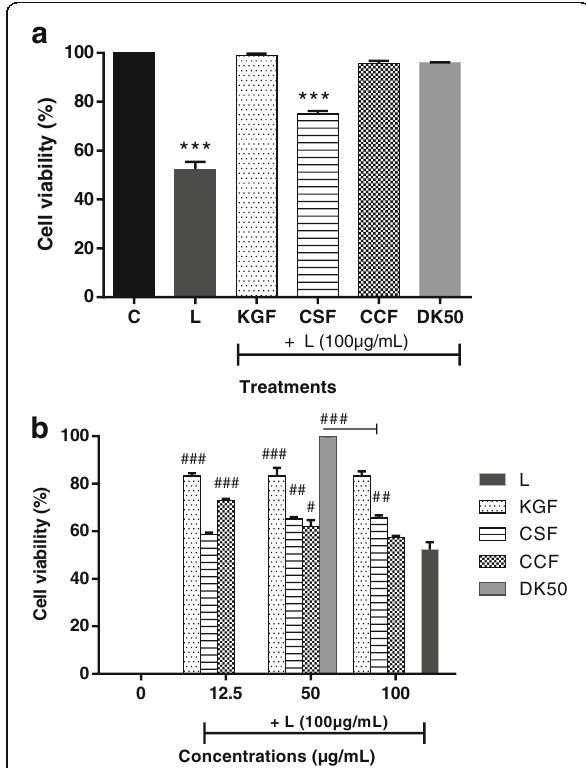
Fig. 4 Effects of polysaccharides isolate from Khaya grandifoliola stem bark (KGF), Cryptolepis sanguinolenta (CSF) and Cymbopogon citratus (CCF) leaves at 12.5 μ g/mL and Diclofenac potassium on the secretion of ROS by LPS-stimulated U87-MG cells. C-control cells; L-LPS (10 μ g/ml), DK50-Diclofenac potassium 50 μ g/mL. Data expressed as mean ± SEM (n = 3). *, **, *** denote statistical significance at p < 0.05, p < 0.01 & p < 0.001 in comparison to the control group. #, ##, ### denote statistical significance at p < 0.05, p < 0.01 & p < 0.001 in comparison to the LPS treated group (Dunnet multiple comparaison, graph Pad Prism